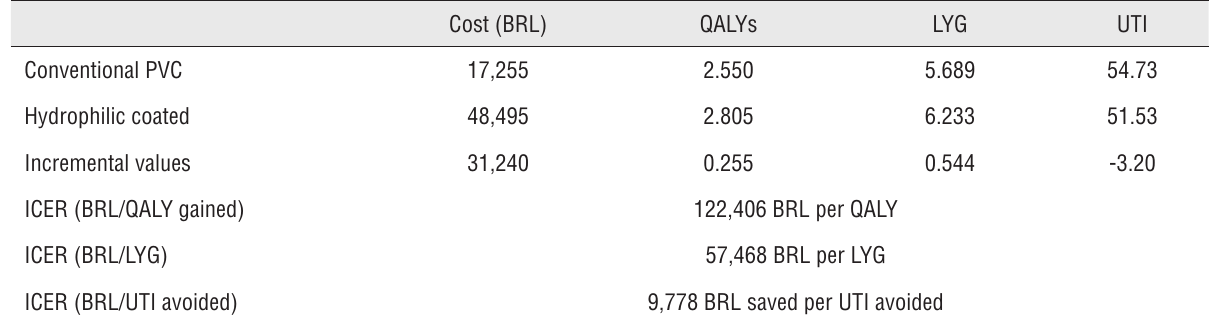
Table 4 - Cost effectiveness results of secondary analysis